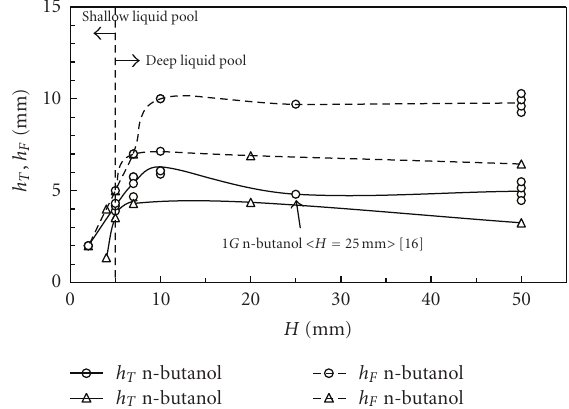
Figure 9: Thermal and flow characteristic depth of subsurface layer circulation versus initial fuel layer